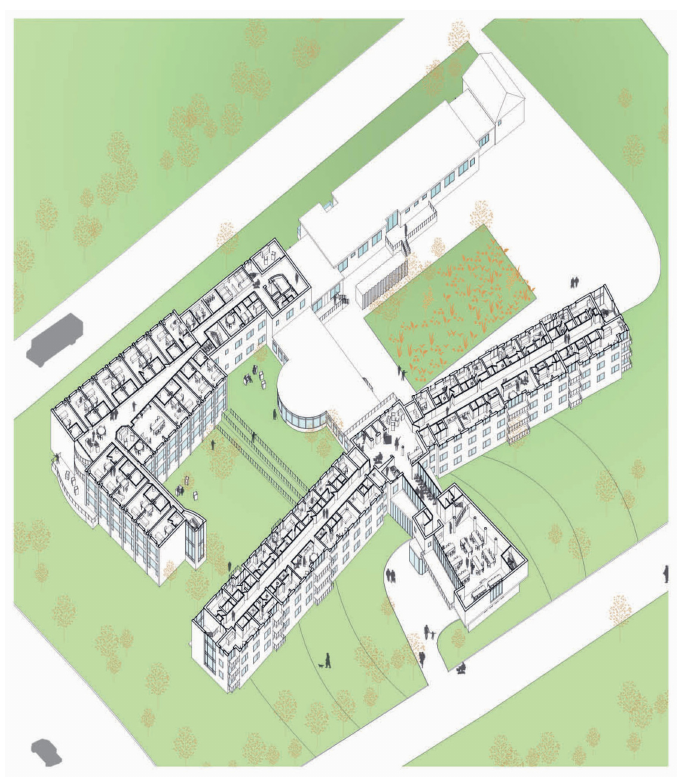
Figure 5 Axonometric view, c (cid:13) Davide